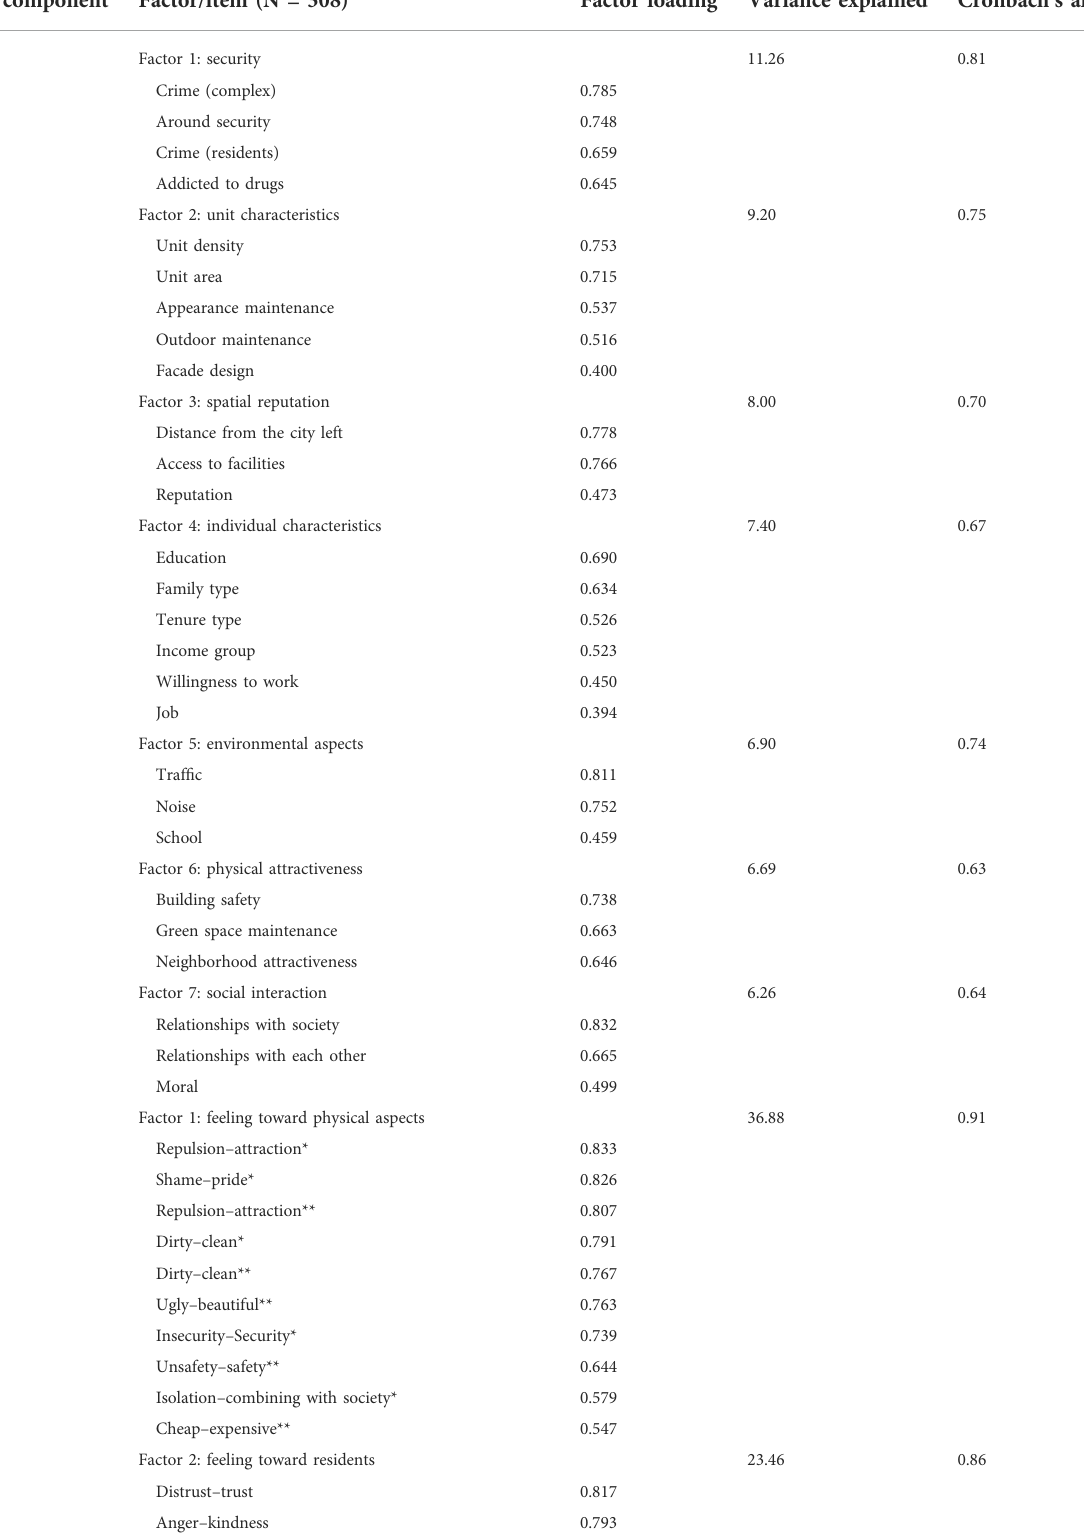
TABLE 2 Eleven-factor matrix extracted after